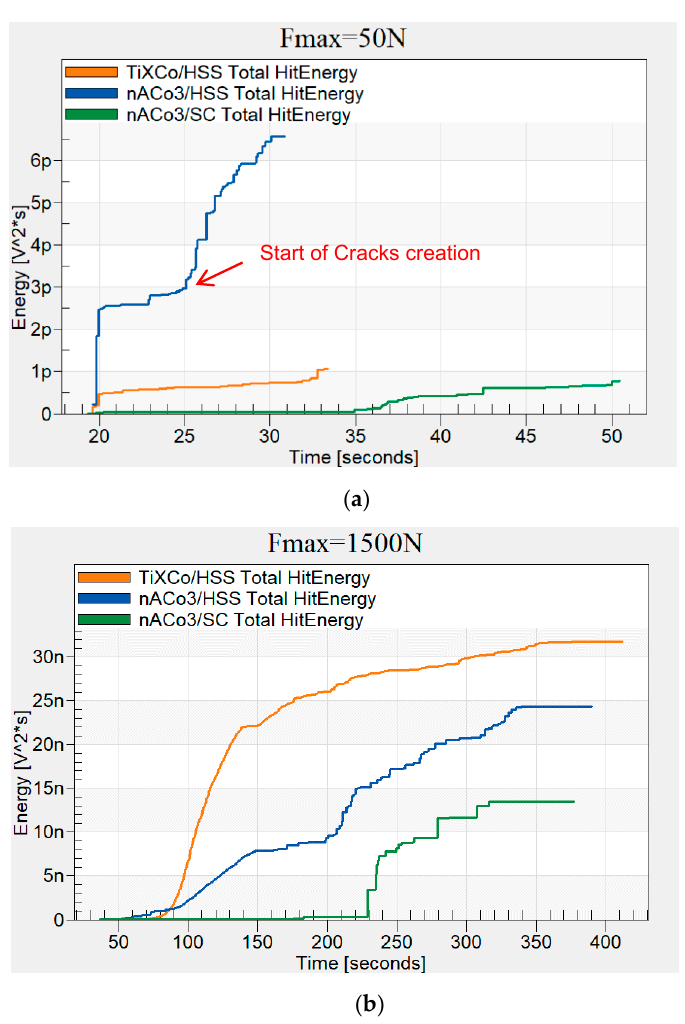
Figure 9. Hits Energy curves for TiXCo3/HSS, nACo3/HSS, and nACo3/SC captured at the maximal force of ( a ) 50 N and ( b ) 1500